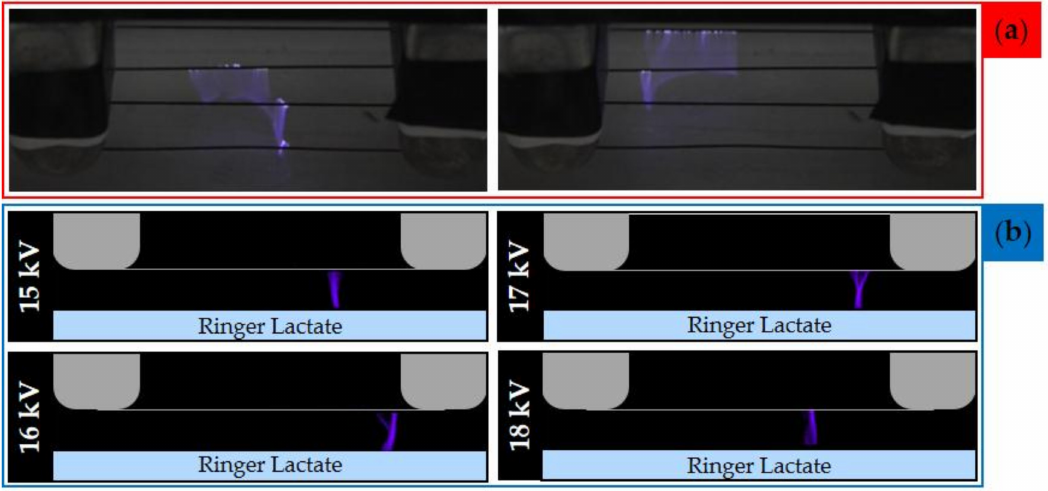
Figure 4. Low-speed images and high-speed (HS) filter images of the multiwire plasma discharge during RL treatment. ( a ) Picture of plasma generated during the treatment of PA-RL with an applied voltage of 18 kV and 30 fps. ( b ) HS filter images of plasma filaments for di ff erent values of applied voltage (between 15 to 18 kV) and 100